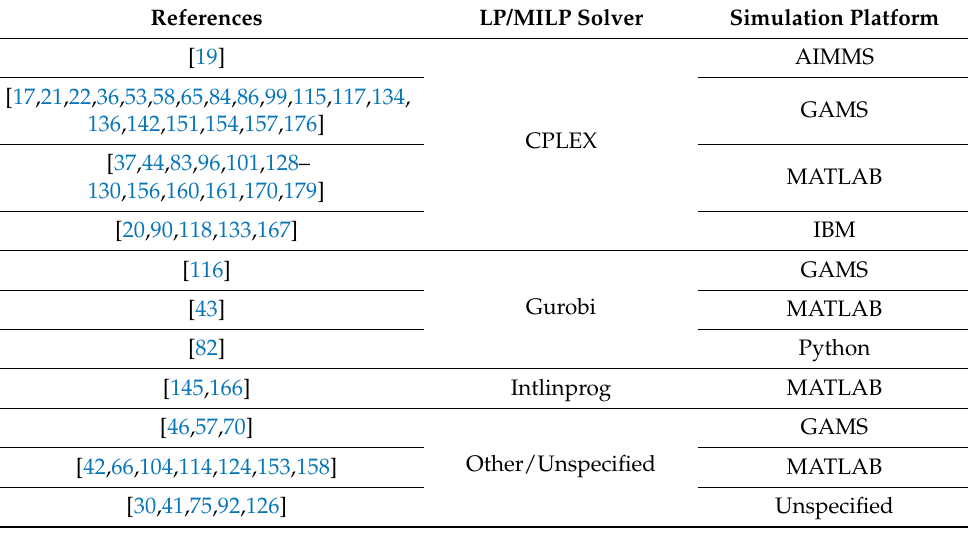
Table 6. Solvers and simulation platforms employed in linear or mixed-integer programs.